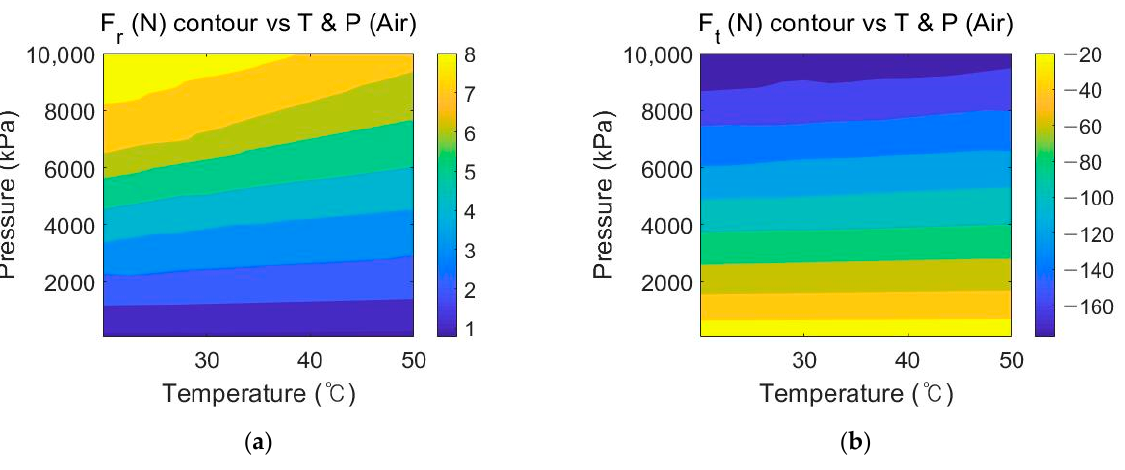
Figure 8. ( a ) 𝐹 (cid:3045) and ( b ) 𝐹 (cid:3047) of air for various conditions (30,000 rpm, ε = 0.05). The calculated 𝐹 (cid:3045) and 𝐹 (cid:3047) values under various conditions for CO 2 show that oper-